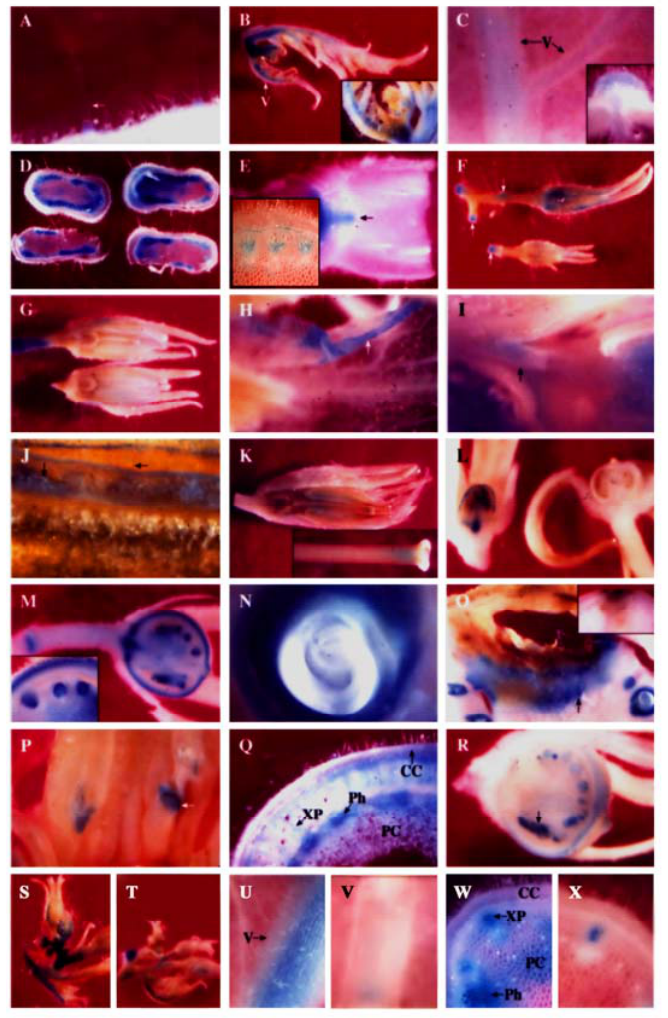
Figure 3. Histochemical staining of β -glucuronidase activities in transgenic PPO B:GUS fusions (at 8× or 40× magnification). A, Type I trichome (arrow); B, Apical leaf. The inset shows young flower buds; C, Apical leaflet at node 4. The inset shows cross-section; D, Stem at internode 4; E, Stem at node 8. Axillary bud (arrow); F, Flowers (3-8 mm); G, Flowers (10 mm); H to J, Anthesis flowers; H, Petal; I, Anther attachment; J, Pollen; K, Post-anthesis flower. The inset shows junction of stigma and style; L, Two fruits (3 mm) collected on the same day from the same plant; M, Fruit (5 mm); N, Green fruit developing ovule; O, Green fruit with blossom end rot. The inset shows no staining in green fruit with blossom end rot of transgenic PPO E:GUS fusion; P, Anthesis flower with stunted anthers (arrow); Q, Stem at internode 8 with elevated expression; R, Fruit (5 mm) with both normally developing ovules and stunted ovules (arrow); S, U and W, Induced PPO B in response to ethylene. T, V and X, PPO B expression in control plants. S and T, Apical leaves and flower buds; U and V, Apical leaflet at node 7; W and X, Stem at internodes 7 and 8. CC, cortical cell; PC, pith cell; Ph, phloem; XP, xylem parenchyma; V,